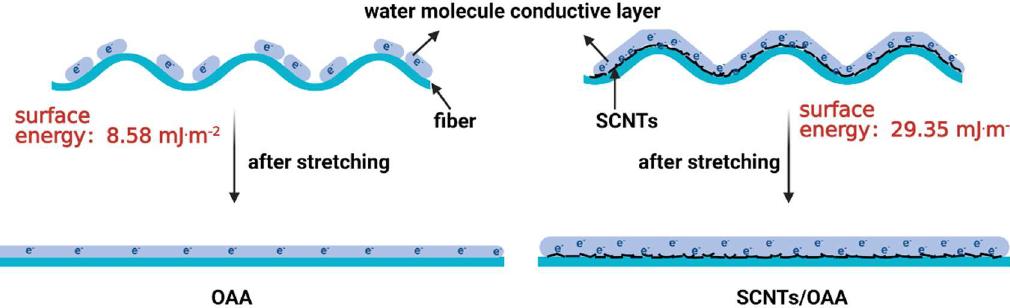
Figure 8. Antistatic mechanism diagram during the stretching process.